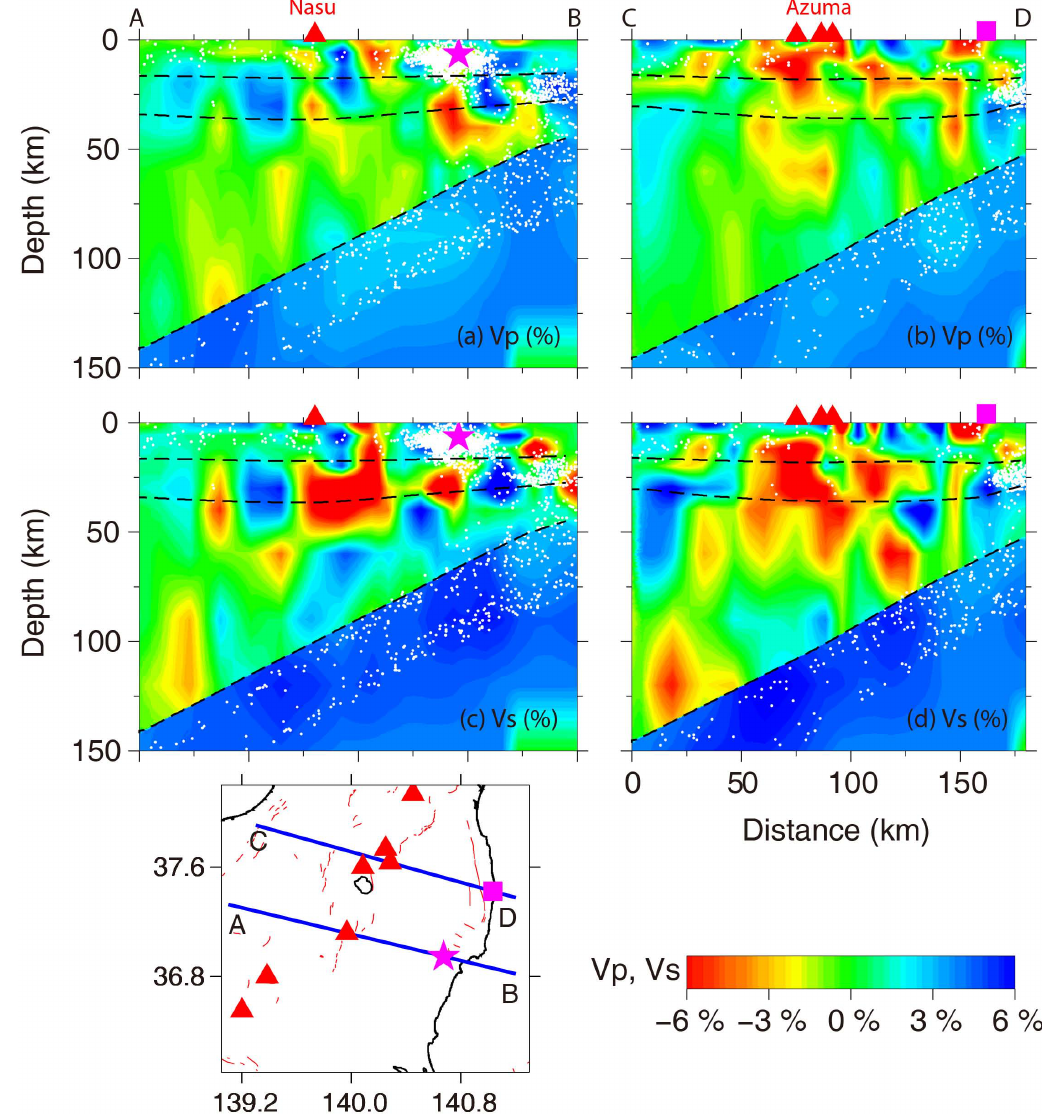
Fig. 6. Vertical cross-sections of (a, b) P-wave and (c, d) S-wave velocity images obtained with the finite-frequency tomography method along the profiles AB and CD as shown on the inset map. The vertical exaggeration is 1:1. Small white dots denote the events during 3 June 2002 to 27 October 2011, which are located within 20-km width along each profile. The purple star and square symbols denote the 2011 Iwaki mainshock (M 7.0) hypocenter and the Fukushima nuclear power plant, respectively. The red triangles represent the active volcanoes. The three dashed lines denote the Conrad and Moho discontinuities and the upper boundary of the subducting Pacific slab. Red and blue colors denote low and high velocities, respectively. The velocity perturbation (in %) scale is shown at the bottom.